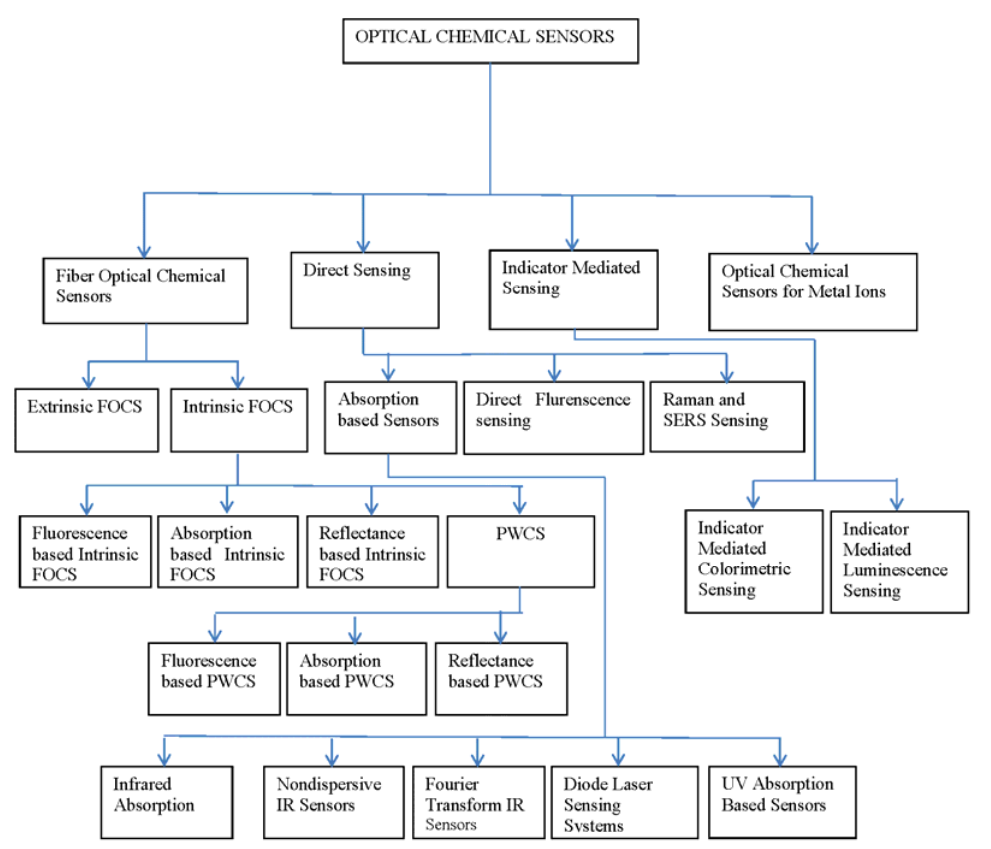
Figure 1. Structure of the